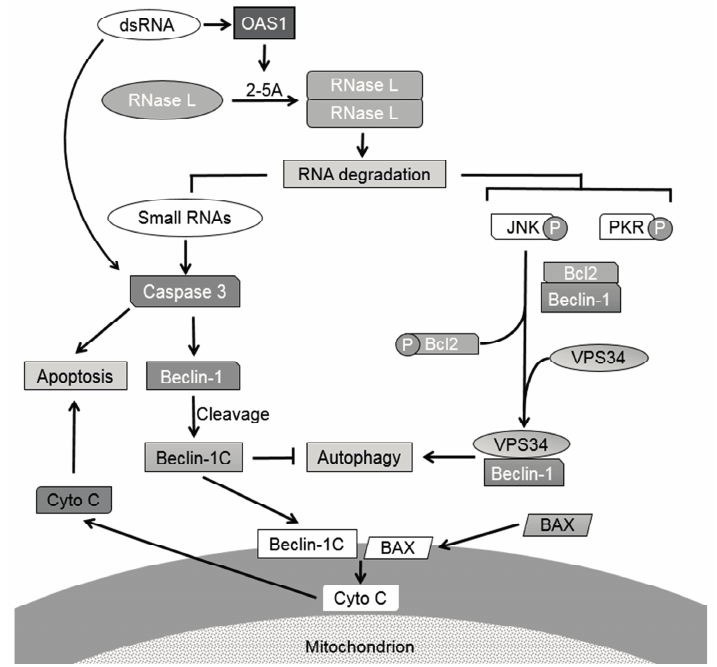
Figure 8. Proposed model of role of RNase L in crosstalk between autophagy and